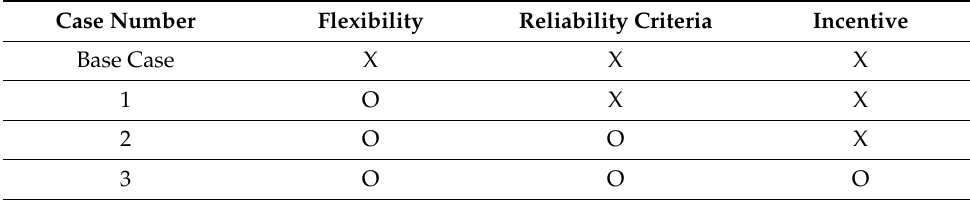
Table 7. Summary of case setup.